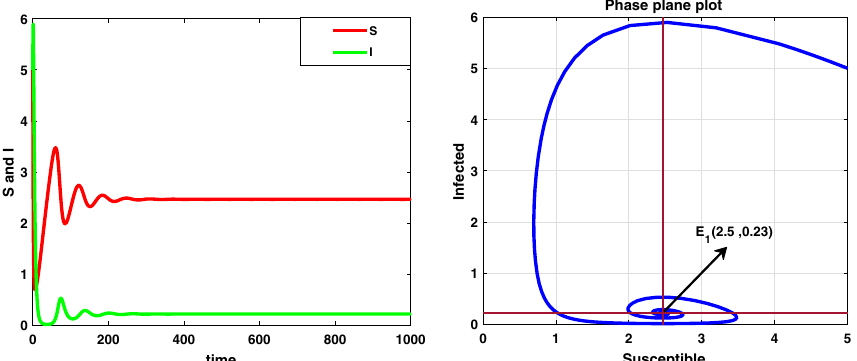
Fig. 3 A dynamic behaviour of system (3.1) with r < µ and the corresponding two-dimensional phase portrait of S,I with susceptible and infected isocline about endemic equilibrium point E